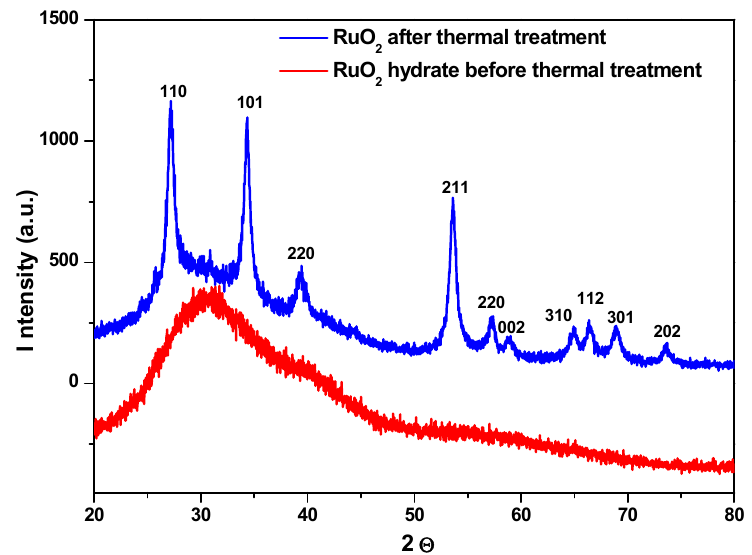
Figure 2. XRD pattern of RuO 2 , before (red line) and after (blue line) thermal treatment. The typical peaks of RuO 2 can be observed after calcination (blue line of Figure 2), which can be indexed as the rutile RuO 2 [25,29], at 2 ϑ = 27.3°, 34.3°, 39.5°, 53.6°, 57.1°, 59.0°, 65°, 66.5°, 68.9° and 73.6°, corresponding to: (1 1 0), (1 0 1), (2 0 0), (2 1 1), (2 2 0), (0 0 2), (3 1 0), (1 1 2), (3 0 1) and (2 0 2), respectively [30].